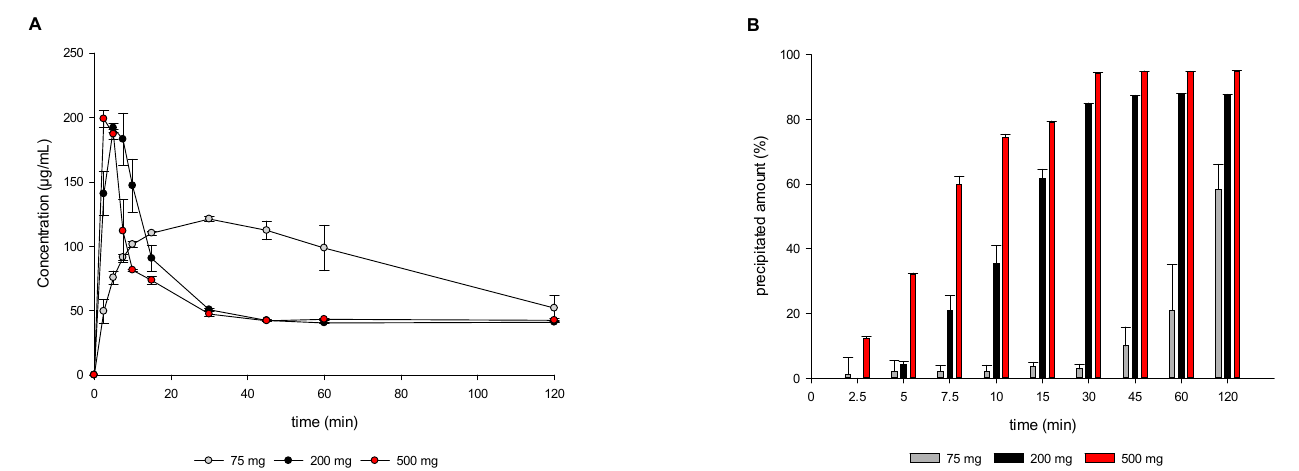
Figure 6. Aqueous phase drug concentration profiles ( A ) and precipitated amount ( B ) obtained from in vitro transfer model experiments using 75, 200, and 500 mg MSC-A as OS. Means ± SD, n = 3.